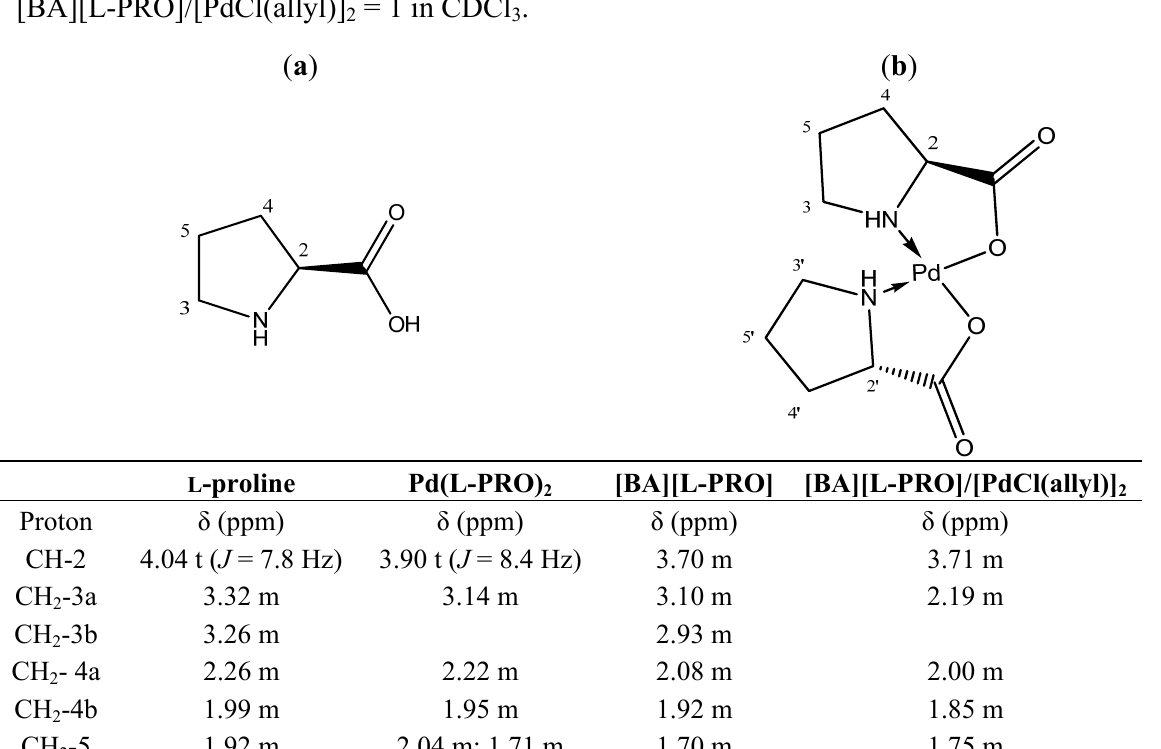
( b ) in D O; [BA][L-PRO] 2 2